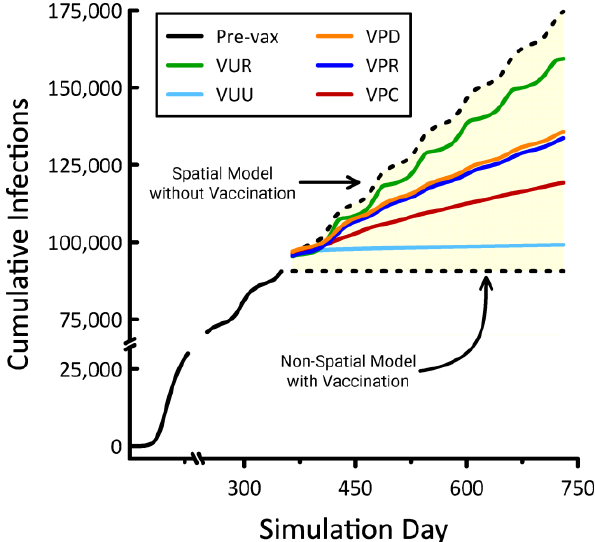
Figure 5. Cumulative infections resulting from five spatial vaccination strategies, the non-spatial model with vaccination, and the spatial model without vaccination. Numbers of infections prior to vaccination are indicated by the solid black line. These models all incorporate social distancing, and the results shown are mean values taken from 10 replicate simulations.